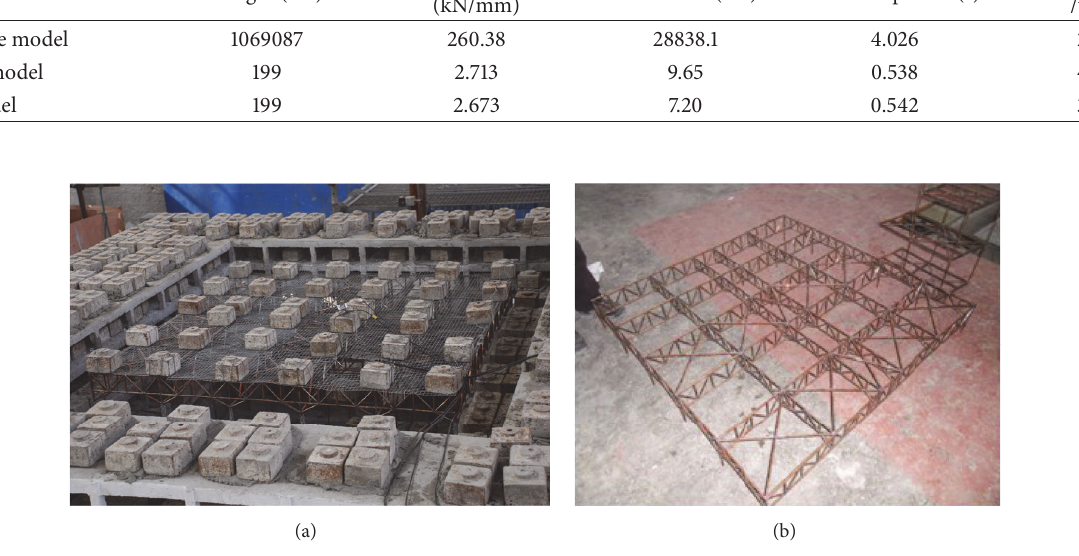
Figure 8: Overview and structural components of “Treasures fill the house”: (a) specimen; (b) joints.